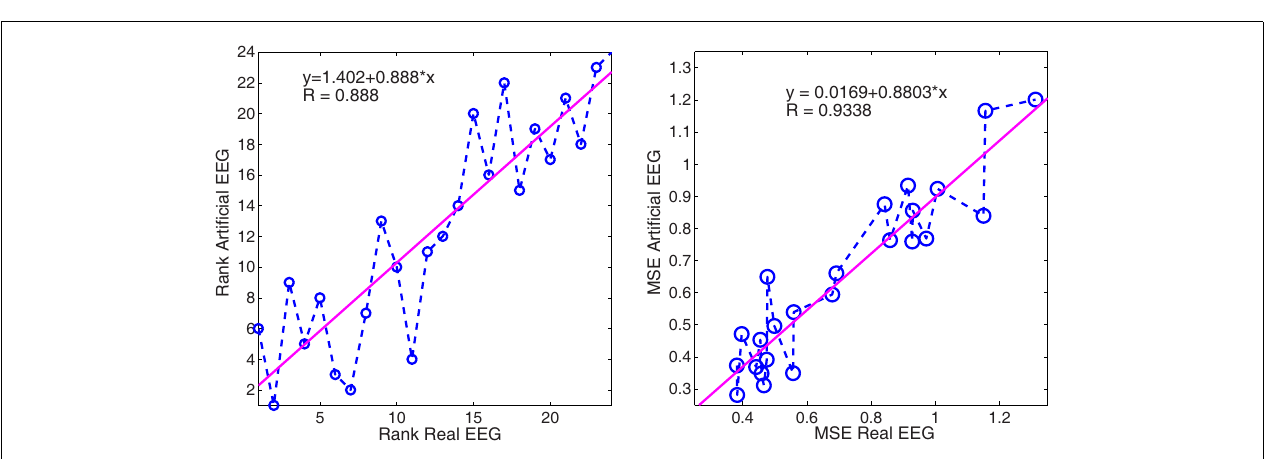
FIGURE 14 | (Data Set 1 – artificial). Linear regression of the rank position (left) and performance of the method (right).The x-axis corresponds to the results submitted for the real EEG data sets, whereas y-axis corresponds to those of the synthetic EEG.